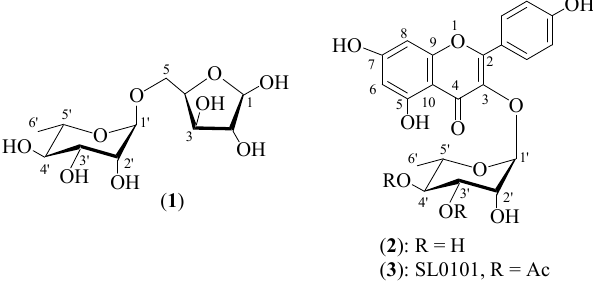
Figure 1. Naturally occurring important rhamnopyranosides ( 1 ), ( 2 ) and ( 3 ).